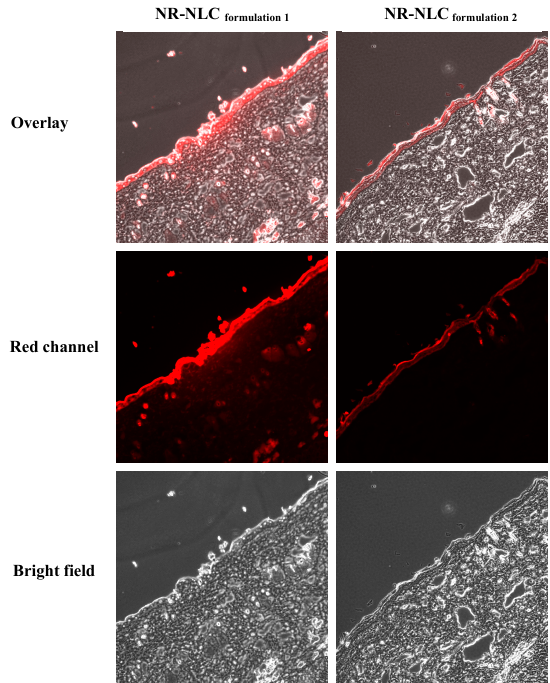
Figure 5. Confocal laser scanning microscopy (CLSM) images of vertical slices (10 μ m) of rat skin, 4 h after the administration of Nile red-loaded NLC (NR-NLC) formulation 1 (109.7 nm) and NR-NLC formulation 2 (219.4